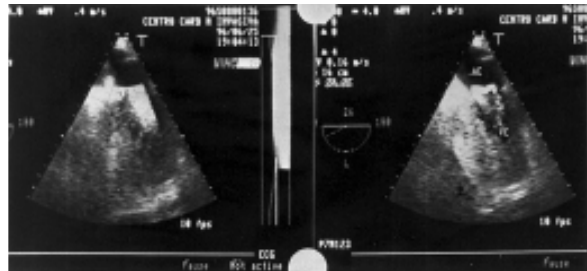
Fig. 2 - Ecocardiograma transesofágico, evidenciando pequeno derrame pericárdico e objeto metálico no ventrículo direito e septo interventricular.